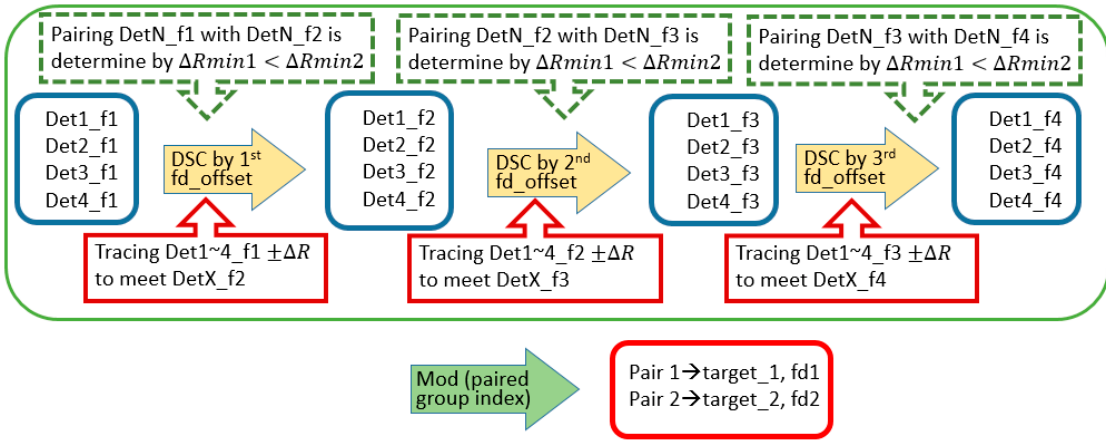
Figure 12. The decision flowchart of the multi-Doppler-shift-compensation (MDSC) scheme. A succinct three-Doppler-filter scenario is applied in this research.